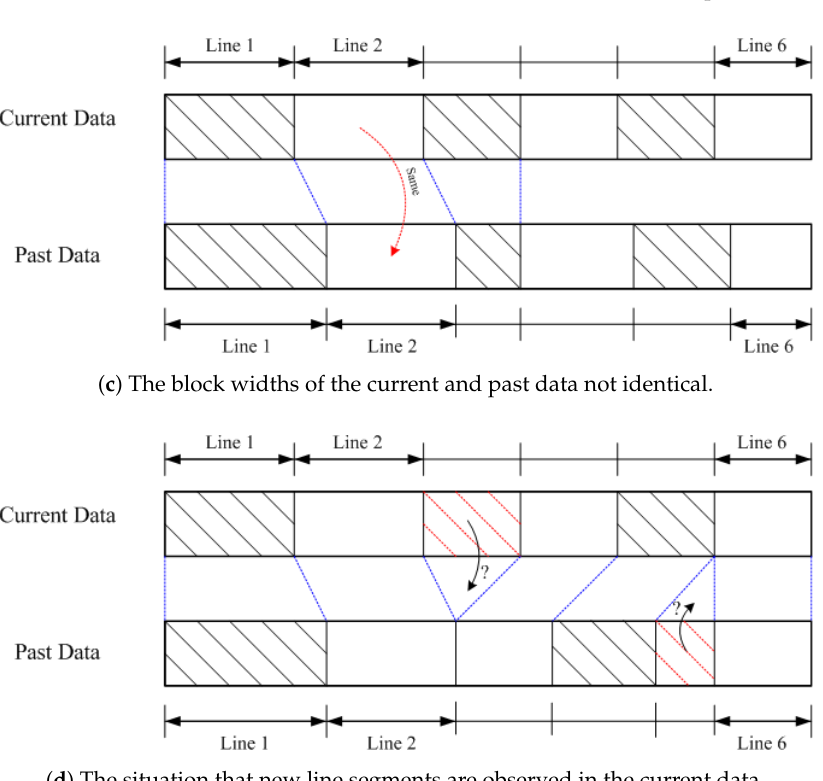
Figure 9. The situations considered to facilitate the line matching between the image frames by tracking. Their orders are always the same since the detected lines are space invariant with respect to the